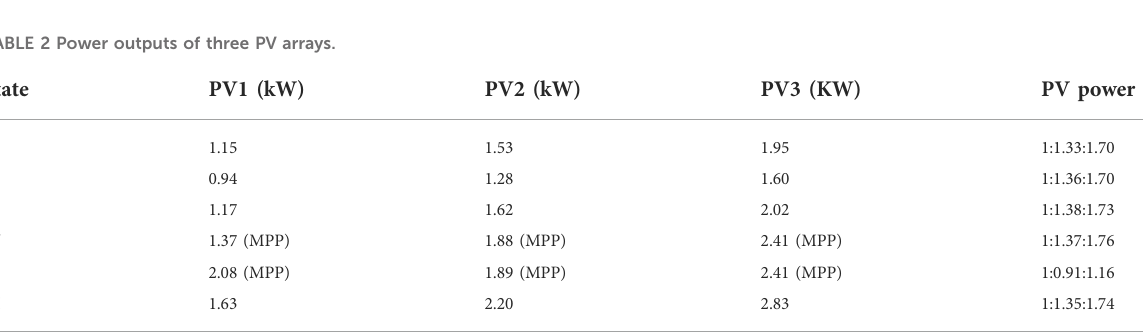
TABLE 2 Power outputs of three PV